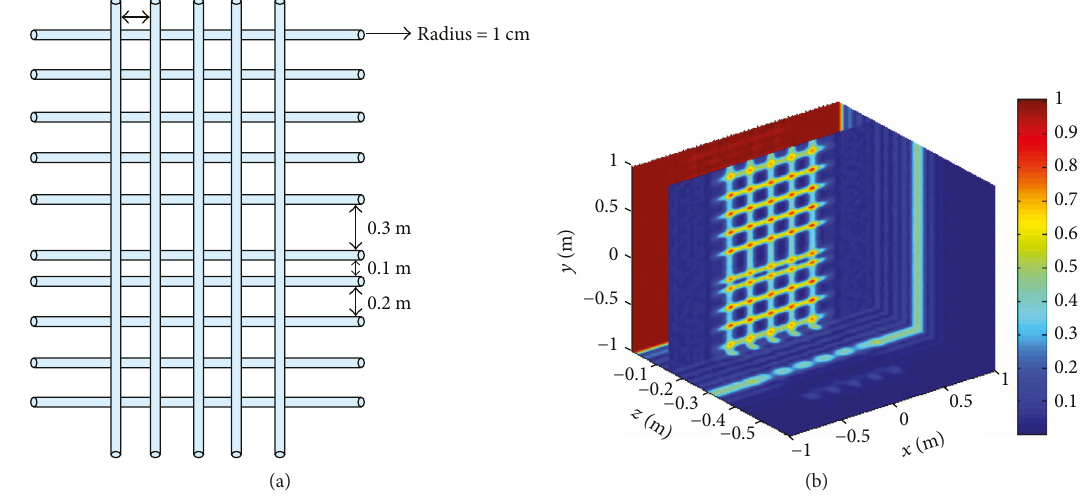
Figure 6: Imaging of the grid reinforcement. (a) Geometrical layout of the reinforcement grid inside the wall. (b) 3-D imaging